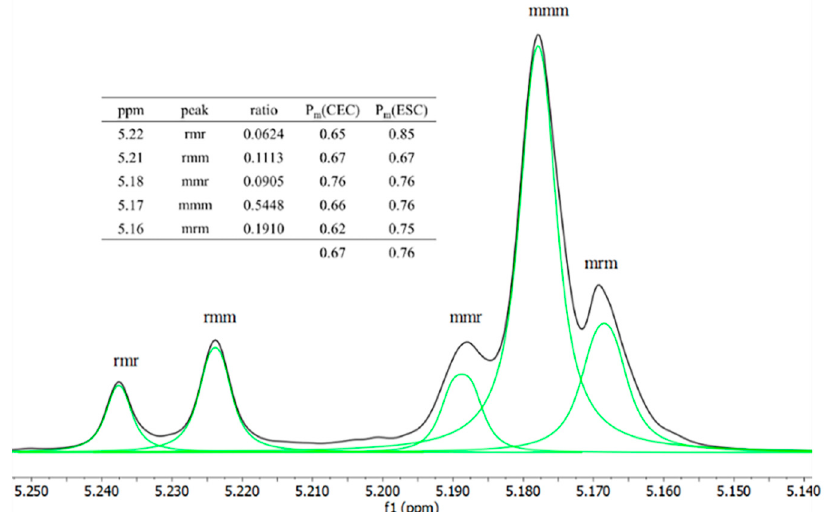
Figure 4. The homodecoupled 1 H NMR spectrum after deconvolution of the sample (run 7, Table 1).